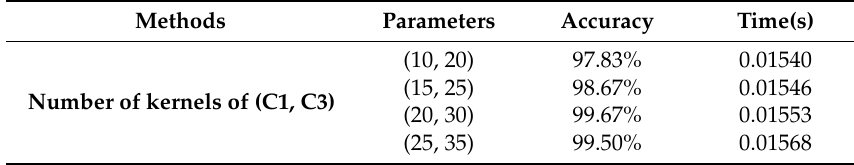
Table 2. Comparison of results with different number of convolutional kernels.